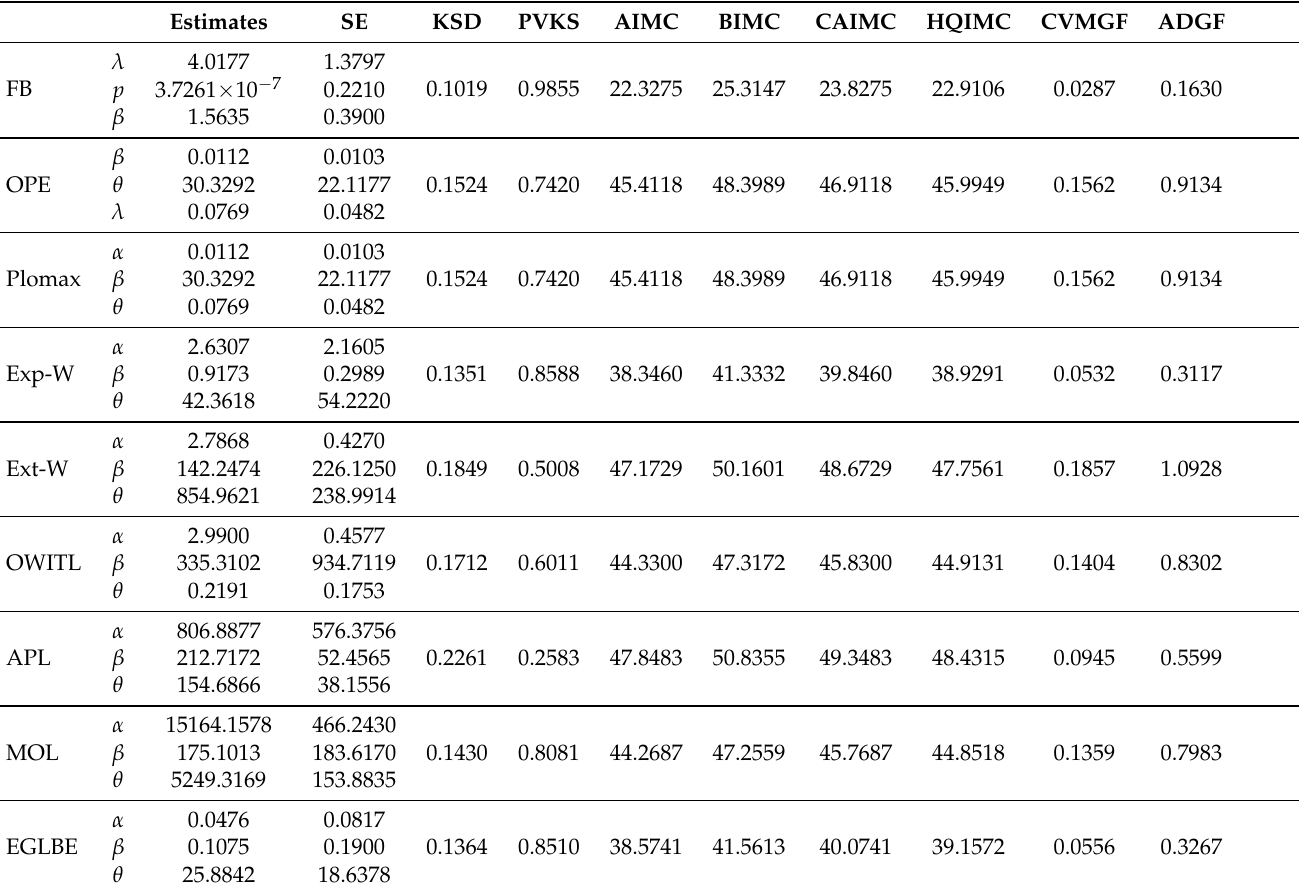
Table 15. MLE with SE and GF measures with different criteria for third set of